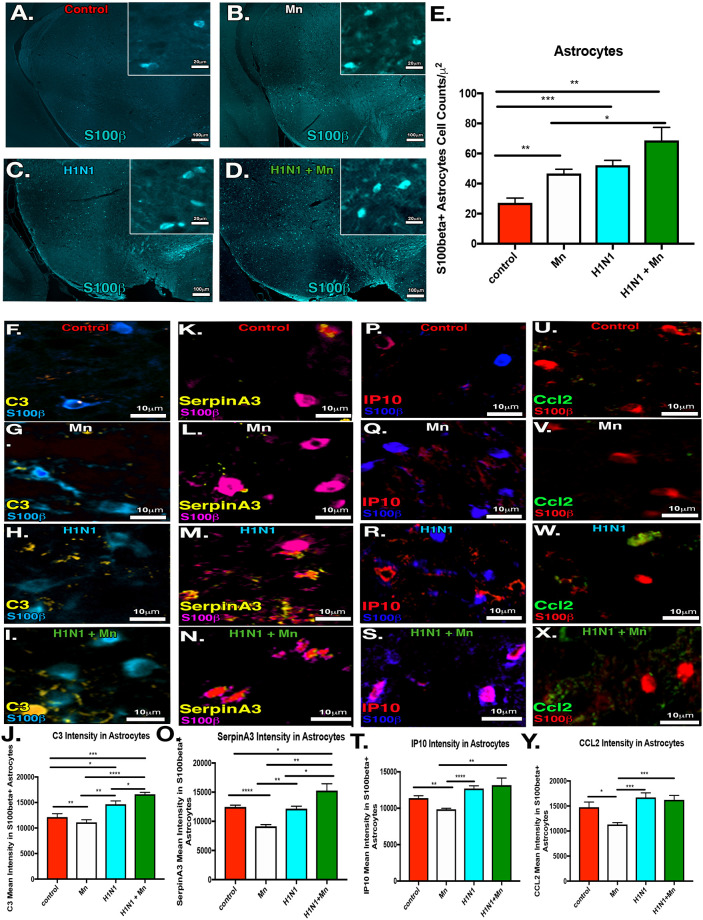
Pre-treatment with manganese induces proliferation and inflammatory activation in astrocytes in the substantia nigra following infection with H1N1.(A-D) IF labeling of astrocytes (s100β). Groups: Control, Mn, H1N1, H1N1+ MnCl2. (E) Cell counts of the s100β+ astrocytes in the substantia nigra pars compacta (SNpc). (F-I) IF colocalization of astrocytes (s100β) with complement C3 (C3). (J) C3 mean intensity measurements in s100β+ astrocytes in the SNpc. (K-N) IF colocalization of astrocytes (s100β) with SerpinA3. (O) SerpinA3 mean intensity measurements in S100β+ astrocytes in the SNpc. (P-S) IF colocalization of astrocytes (s100β) with complement IP-10/Cxcl10 (IP-10). (T) IP-10 mean intensity measurements in s100β+ astrocytes in the SNpc. (U-X) IF colocalization of astrocytes (s100β) with complement Ccl2. (J) Ccl2 mean intensity measurements in s100β+ astrocytes in the SNpc. *P<0.05 **P<0.01 ***P<0.001****P<0.0001. n = 6 mice/group.